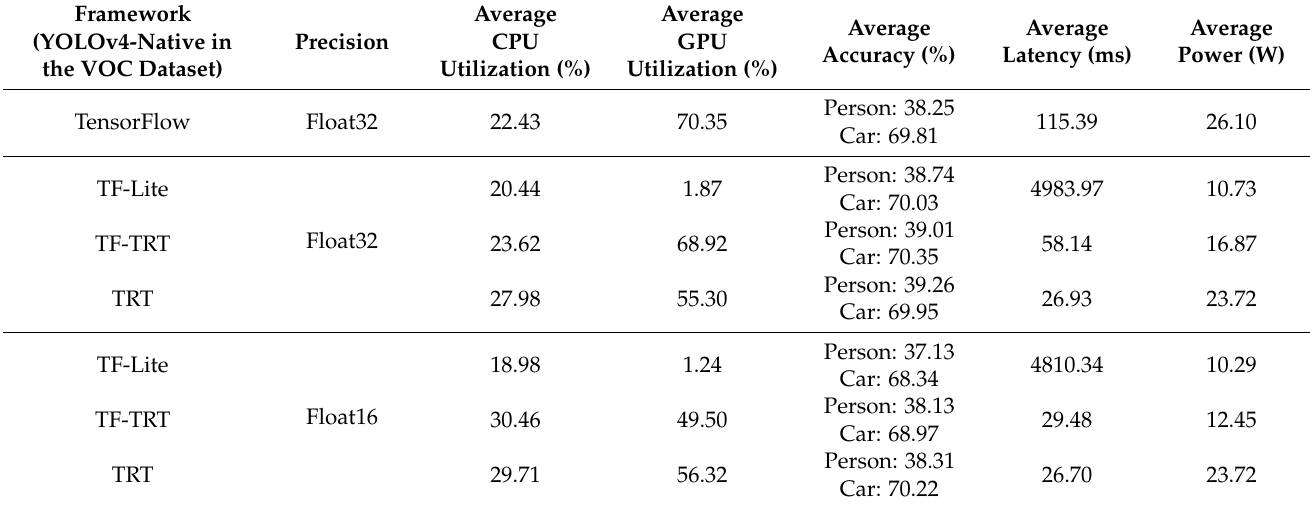
Table 4. Comparative analysis of YOLOv4-Native.weights’s inference performance in the PASCAL VOC